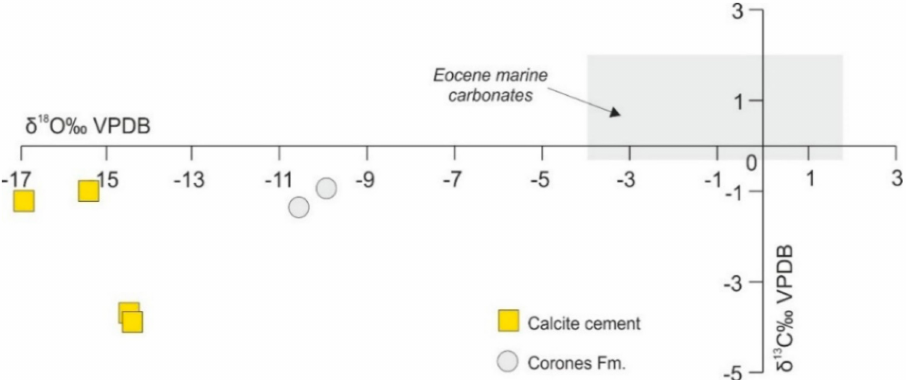
Figure 8. δ 18 O vs. δ 13 C cross-plots of the Corones Formation and bladed calcite crystals. Range for the Eocene marine carbonates from Reference